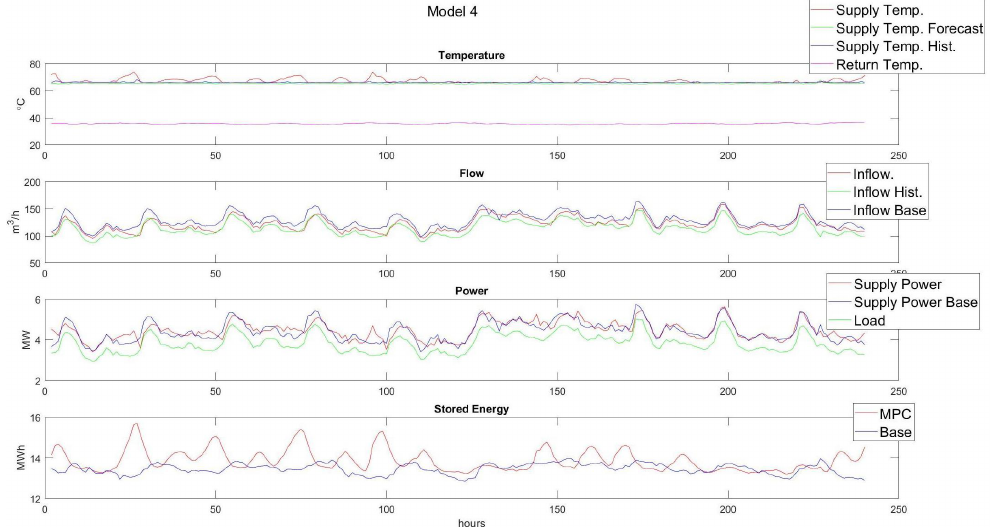
Figure 9. Performance results of model 4, inducing peak shaving but also inducing large peaks. MPC results (red), base simulation (blue), and historic results